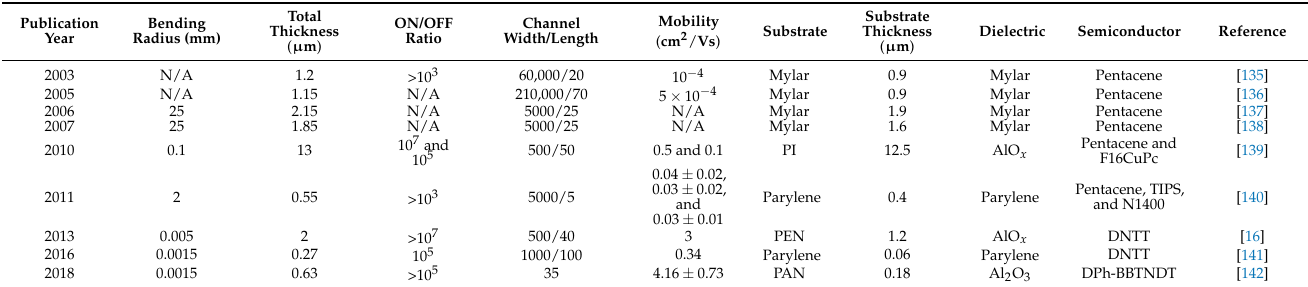
Table 5. The detailed properties of the organic TFTs in Figure 11.